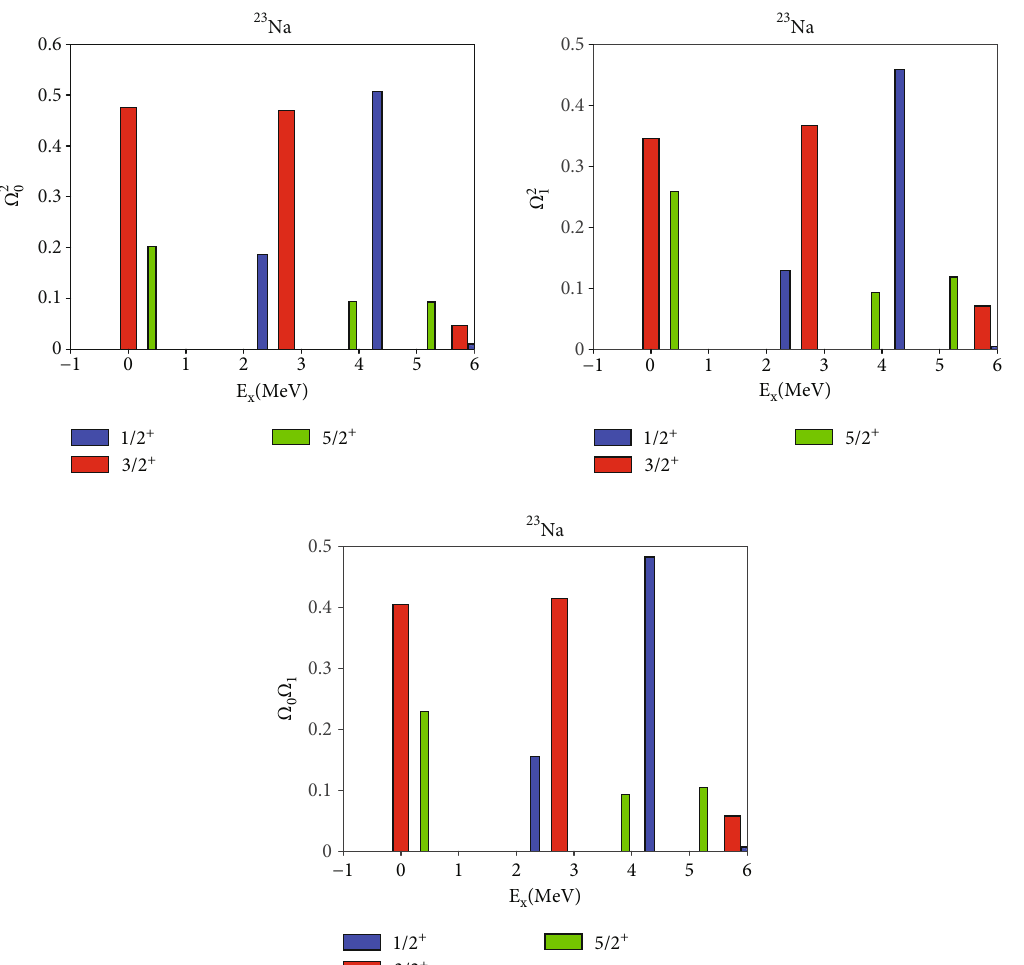
= 3/2 + to J relevant for axion i f gs − E ; i.e., the maximum photon energy a x